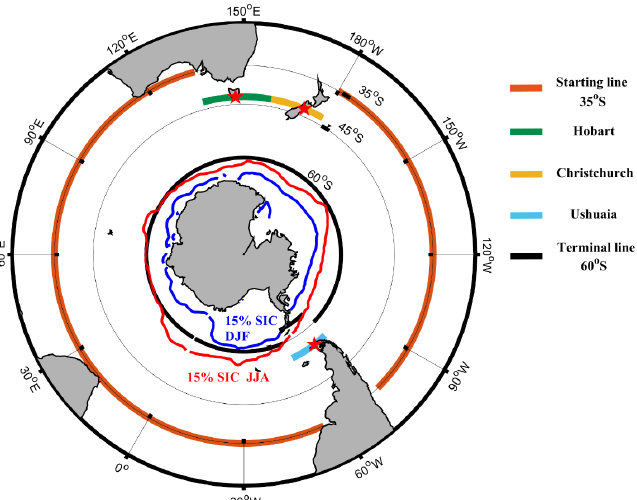
Figure 1. Schematic diagram of the starting and terminal locations of the routes crossing the westerlies toward Antarctica. Three ports, Hobart, Christchurch, and Ushuaia, are marked with red stars. The black solid line at 60° S and the area inside it are the locations indicating where vessels cross the westerlies. The blue and red lines mark the 15% sea ice extent in austral summer and austral winter, respectively.